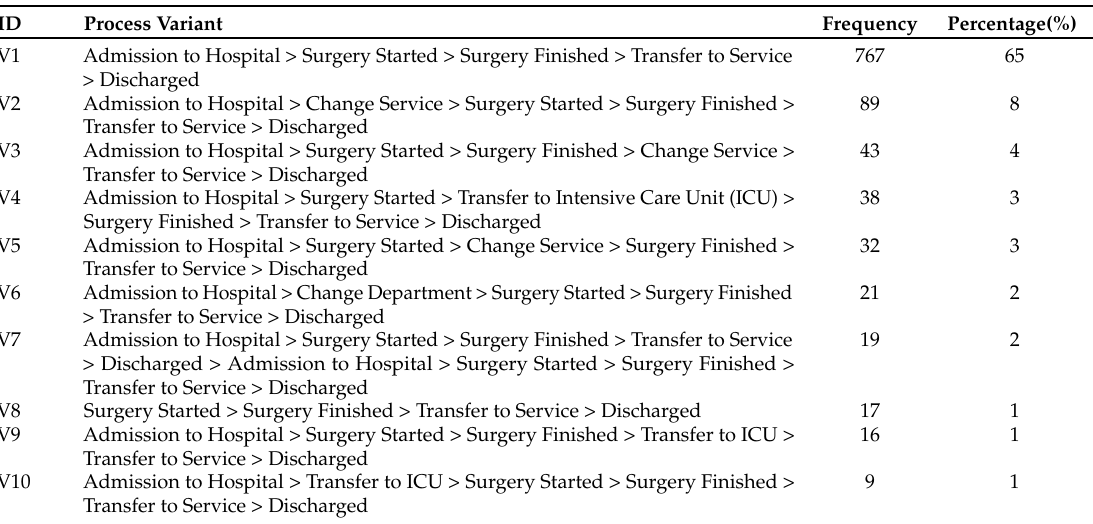
Table 7. The most frequent process